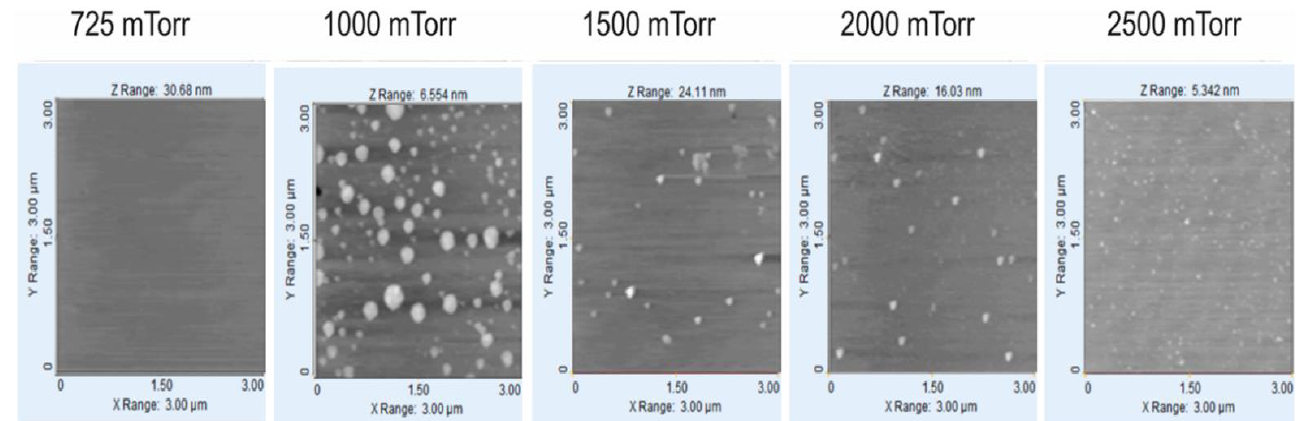
Figure 7. Images of surface of a-Si:H films deposited over glass substrate with flows of H 2 = 4000 sccm and SiH 4 = 200 sccm.